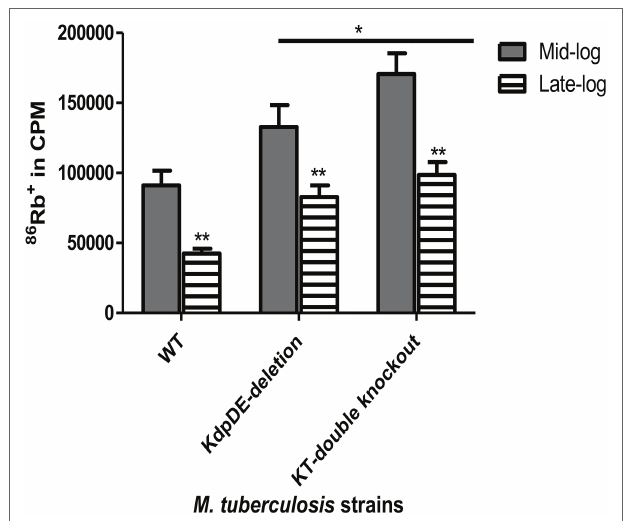
FIGURE 3 | Rubidium ( 86 Rb + ) uptake by the WT and the K + -uptake-deletion mutant strains at the mid- and late-log phases. The results are of five experiments with three replicates for each time point represented as absolute counts per minute (cpm). The gray and striped bars represent uptake of 86 Rb + at the mid- and late-log phases, respectively. The cpm values were 91,041 ± 10464.87, 132748.3 ± 15,650, and 170577.3 ± 4877.88 at the mid-log phase and 42431.48 ± 3447.031, 82737.71 ± 8308.834, and 98569.04 ± 9211.451 at the late-log phase for H37Rv (WT), KdpDE-deletion, and KT-double knockout strains, respectively. Statistical differences at p < 0.05 are represented by * and **. *Values of p represent comparison of the responses of the WT strain relative to those of the mutant strains at the mid- and late-log phases and were 0.0397 and 0.0006 for the KdpDE- deletion and KT-double knockout mutant strains, respectively at the mid-log phase, while they were 0.0001 for both mutant strains at the late-log phase. The **values of p represent comparison of responses in each strain between mid- and late-log